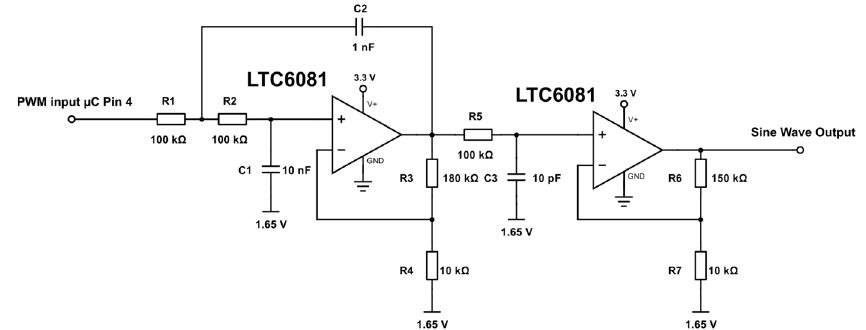
Figure 10. Circuit schematic of the square wave to sine wave converter based on a second-order Sallen-Key low-pass-filter (left amplifier) and active low-pass filter (right amplifier) design.